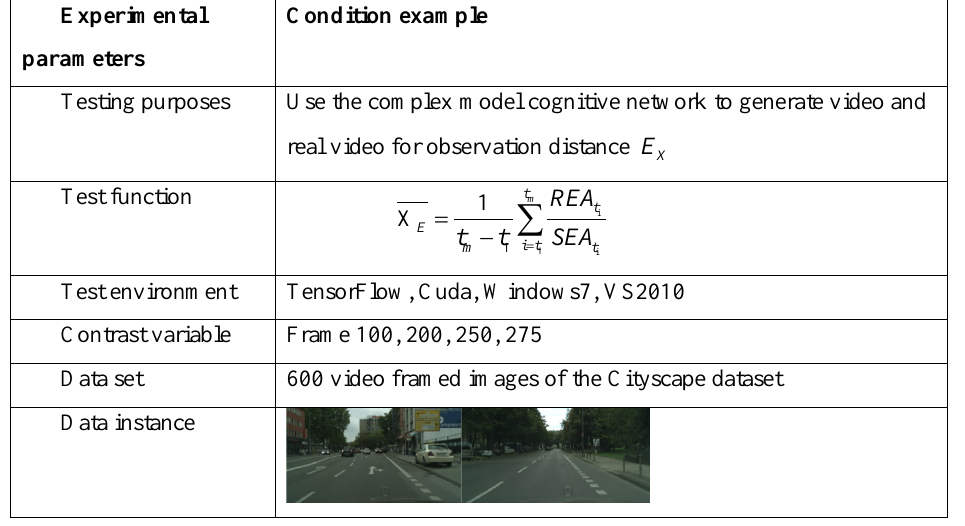
Table 3 Experimental information table of the relationship between generated knowledge and generated